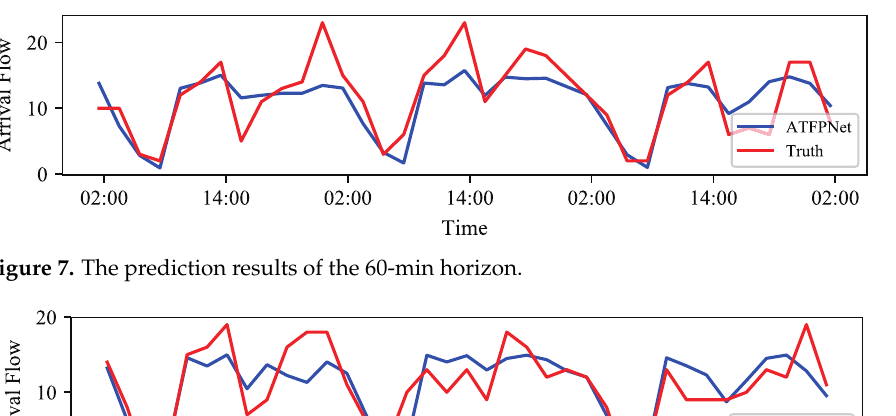
Figure 6. The prediction results of the 30-min horizon.